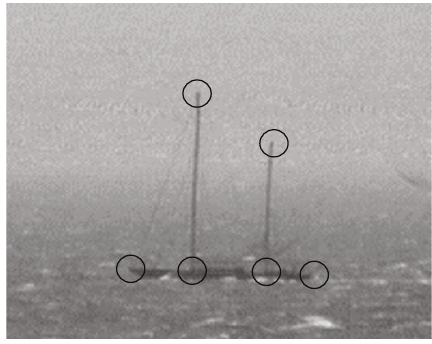
Figure 8: Photo of the two-mast